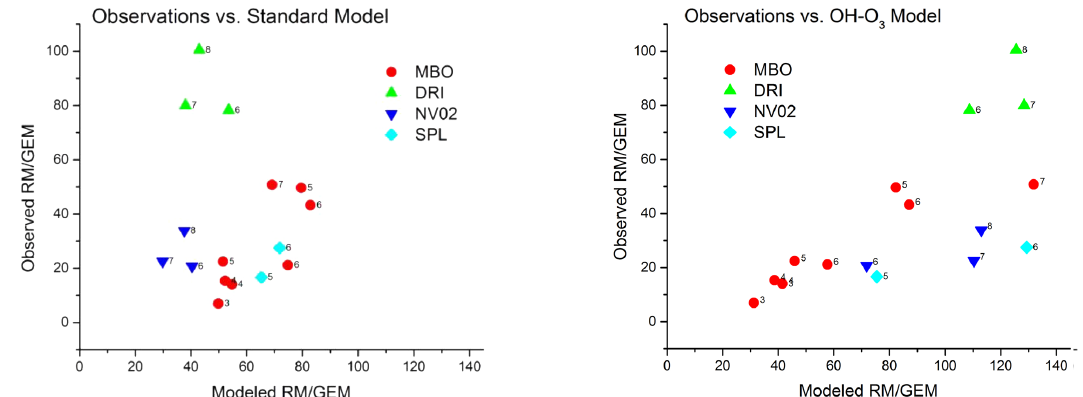
Figure 7. Plots of monthly mean RM / GEM from the observations vs. monthly mean RM / GEM in the standard model (left panel) and vs. monthly mean RM / GEM in the OH–O 3 model (right panel). The units arepgng − 1 . The month is indicated by the labels on each data point. Only data from summer 2007 were considered for DRI, since the model with OH–O3 chemistry was not run for all time